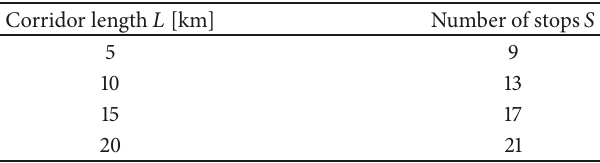
Table 1: Lengths and number of stops considered in the analysis. Corridor length 𝐿 [km] Number of stops